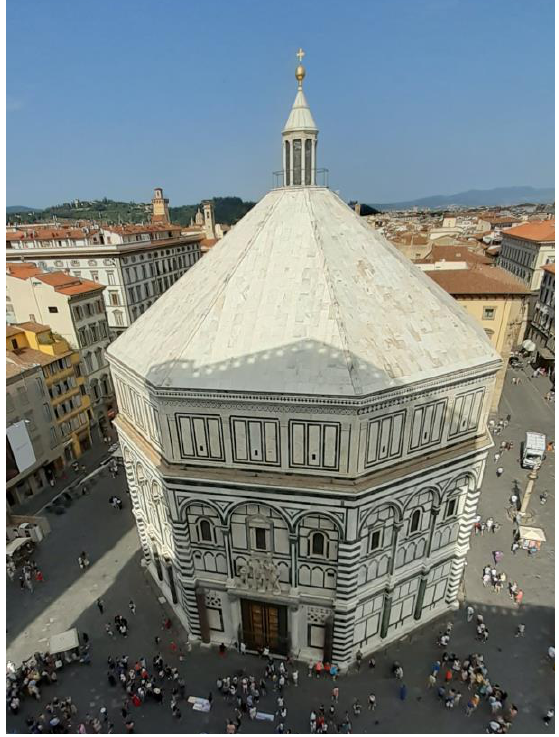
Figure 1. The Baptistery of San Giovanni as seen from the terrace of the Santa Maria del Fiore cathe- dral.